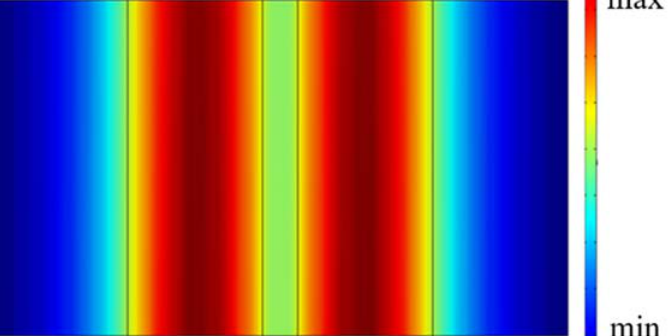
Figure 5. ( a ) Thickness-twist strain distribution u